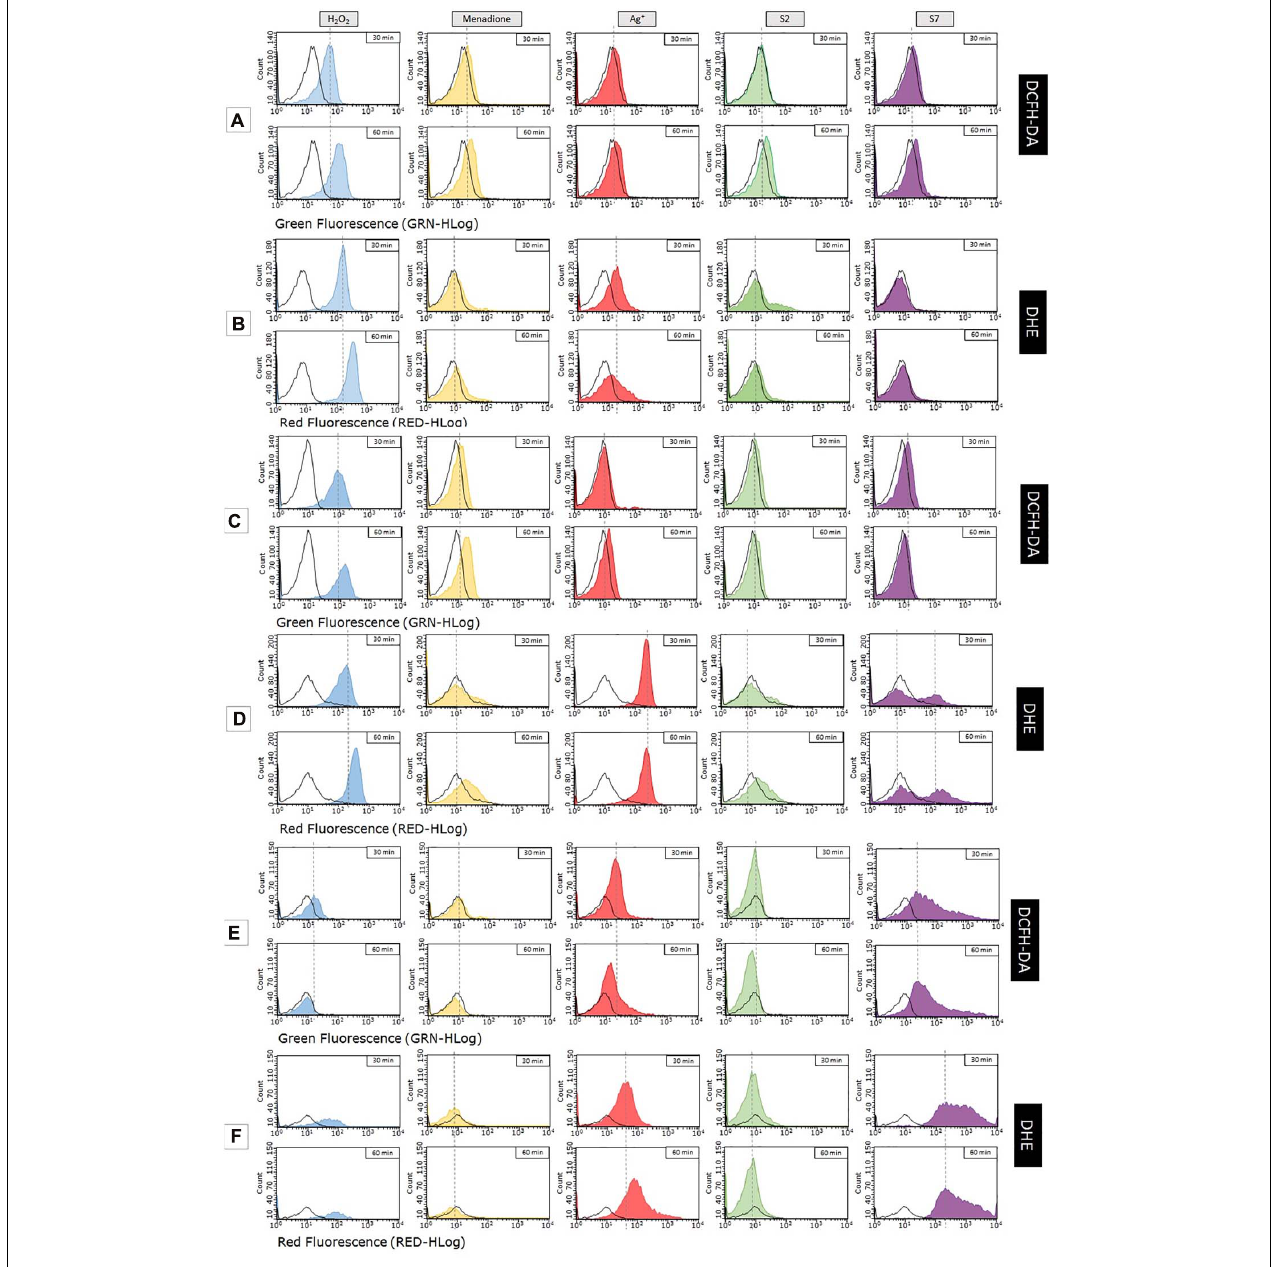
FIGURE 2 | Measurement of reactive oxygen species generated in bacterial cells after exposure to nanosilver compounds with different physico-chemical properties. Research was carried out on 2 fluorescent dyes (DCFH-DA, DHE). Tested strains of Escherichia coli – BW25113 (A,B) , its mutant marked as AgR (C,D) and E. coli J53 (E,F) – were exposed to MIC concentration of AgNO 3 (red), S2 (green), S7 (violet), H 2 O 2 (blue – control), menadione (yellow – control) or left untreated (black – control).